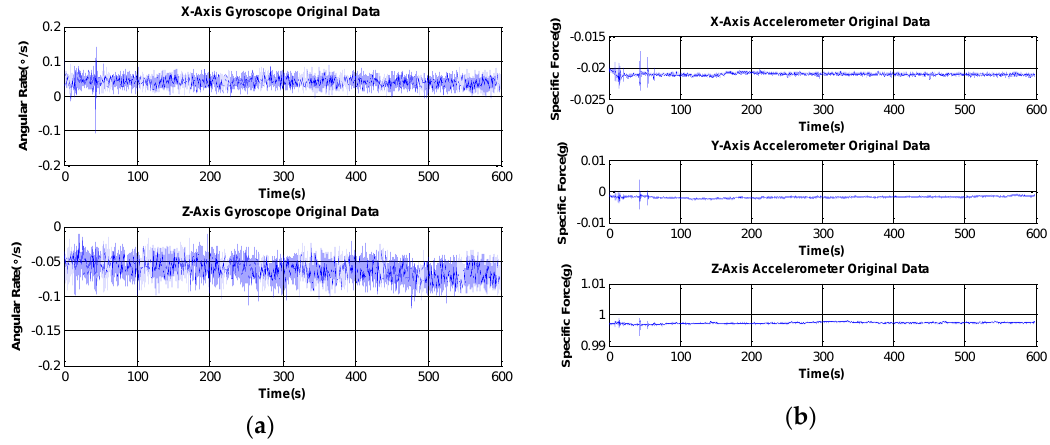
Figure 5 . Original data obtained from experiments using the MGWD device. ( a ) Original data from two-axis gyroscopes; ( b ) original data from three-axis accelerometers. The length of experimental data is 600 s in quasi-stationary conditions.